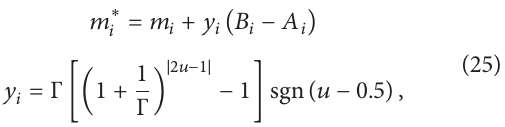
Algorithm 2. Calculation method for OD matrix.